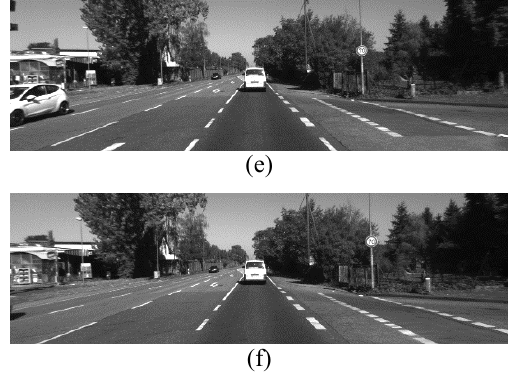
Fig. 16 Stereo images downloaded from KITTI.